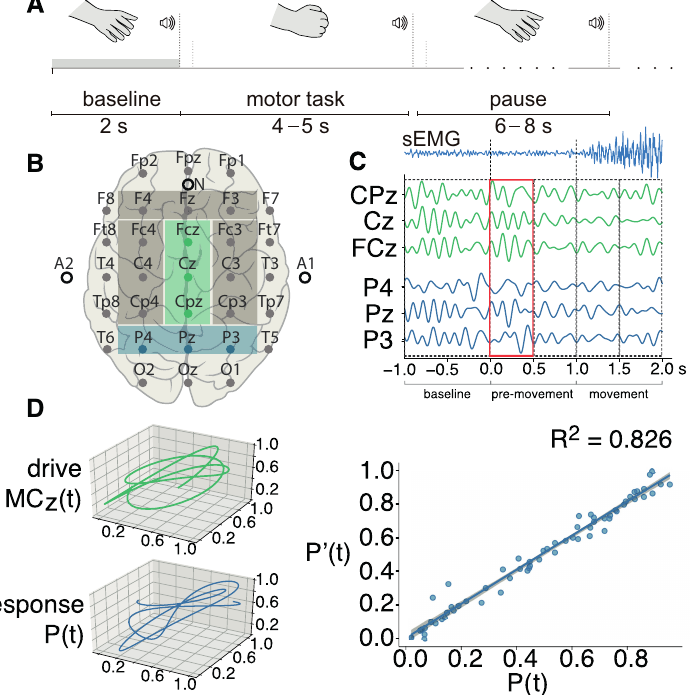
Figure 1. ( A ) The timeline of the single motor task; ( B ) the “10–10” international system of electrodes placement used in this study, with the areas of interest selected with colored rectangles. The green rectangle corresponds to the midline motor cortex ( MCz = { Cpz , Cz , FCz } ), and the blue area highlights the parietal lobe ( P = { P 4, Pz , P 3 } ); ( C ) an example of EEG data filtered in the theta-band (4–8 Hz). Here, functional connectivity is computed between the brain areas MCz and P , based on multivariate EEG recordings. In the upper row, the sEMG averaged over the YA group is shown. The sEMG signal is filtered in the range of 10–100 Hz; ( C ) three-dimensional trajectories of subsets MCz and P ; ( D ) the inference of functional dependence, where P ( t ) is the response state and P (cid:48) ( t ) is the state predicted by the proposed FF-MLP model based on the drive